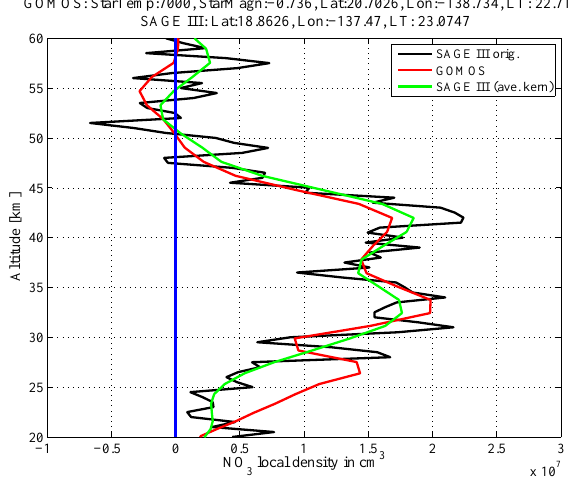
Fig. 4. An individual match between GOMOS and SAGE III show- ing good agreement. SAGE III profile is plotted before and after the GOMOS averaging kernel was applied. Figure 4 illustrates two- peaked NO 3